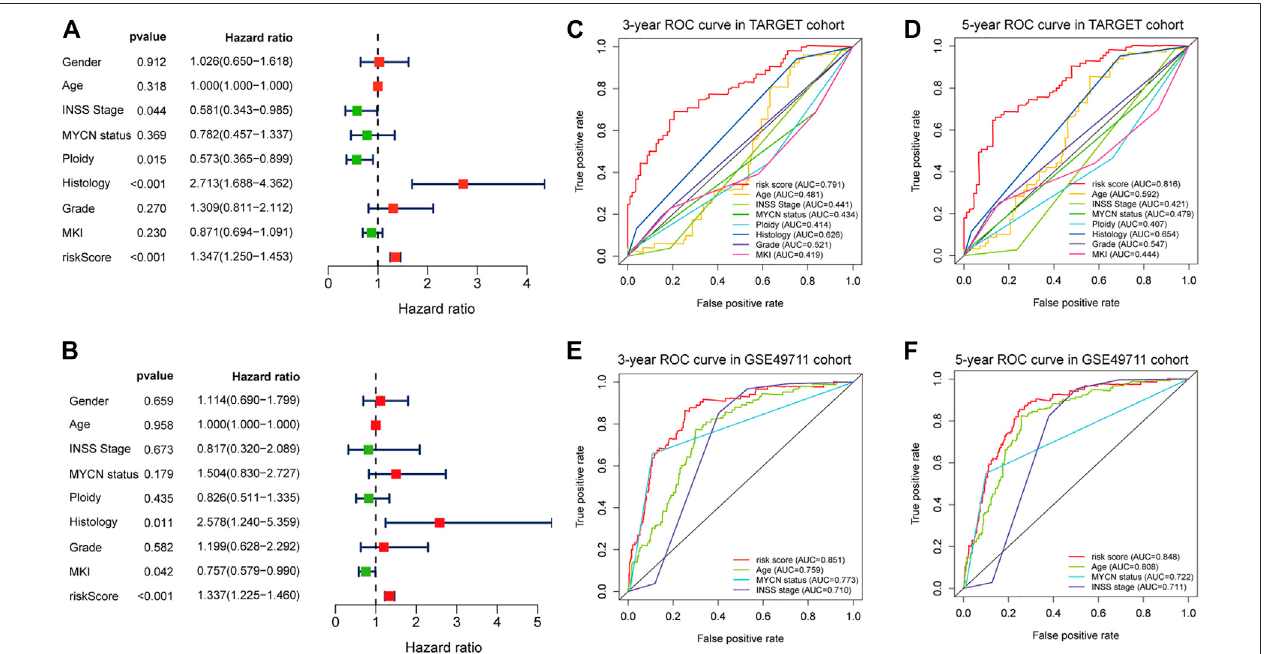
FIGURE 6 | Estimate the predictive ability of the fi ve-RNA-based risk signature. Univariate Cox regression analysis of risk score and clinical factors (A) . Multivariate Cox regression analysis of risk score and clinical factors (B) . The receiver operating characteristic (ROC) curve for 3-years (C) and 5-years survival (D) for overall survival (OS) in the TARGET cohort. The ROC curve for 3-years (E) and 5-years survival (F) for OS in the GSE49710 cohort.